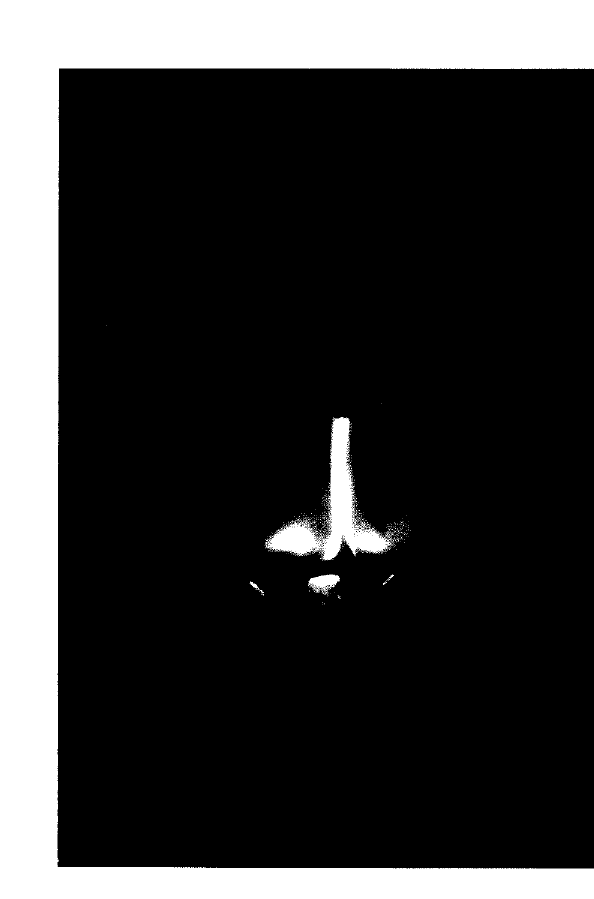
Fig. 9 TEM photograph of amorphous fibers from Cl NH 3 and SiH 2 2